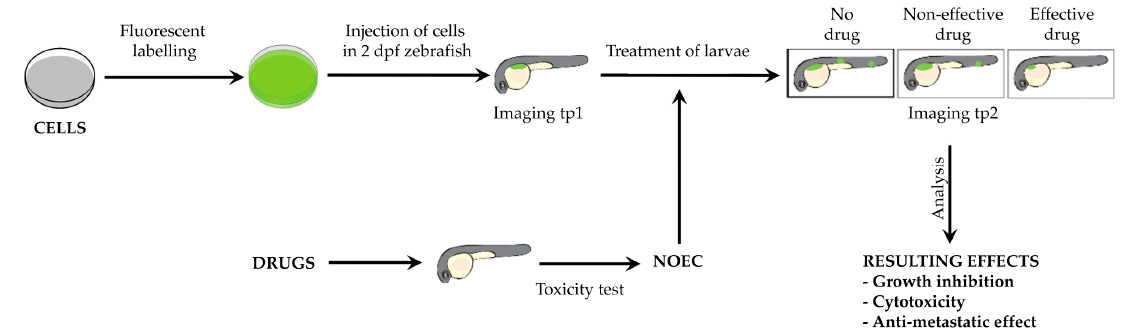
Figure 1. ZeOncoTest pipeline. Fluorescently labeled cells are injected in 48 hpf larvae, subsequently imaged at tp1. After the first imaging, xenotransplanted larvae are incubated at 35 °C with the NOEC of candidate drugs, previously calculated. Subsequent imaging is performed at tp2. The evaluation of drug impact on tumor growth and metastatic potential is given by the calculation and comparison of tumor mass and dispersion of cells at the 2 time points, in treated and untreated animals.